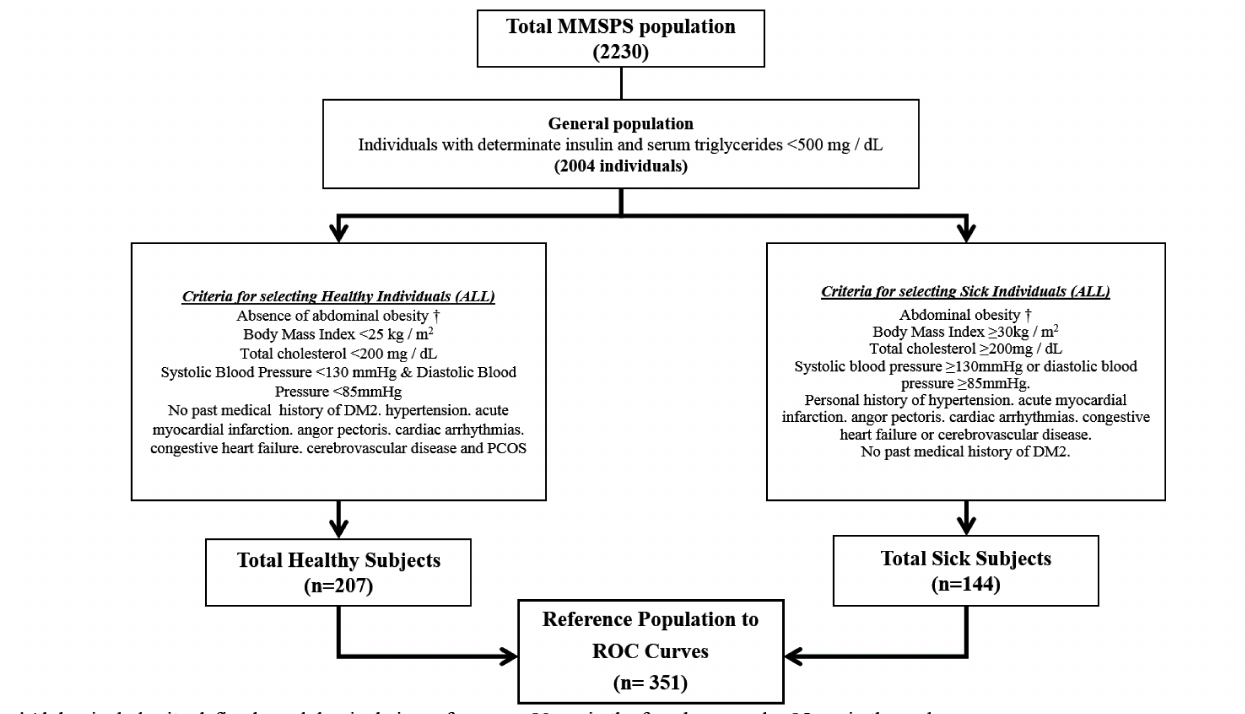
Figure 1. Diagram of reference population selection for cut-off points determination of the triglyceride-glucose index in Maracaibo city, Venezuela. ROC Curves: Receiver operating characteristic